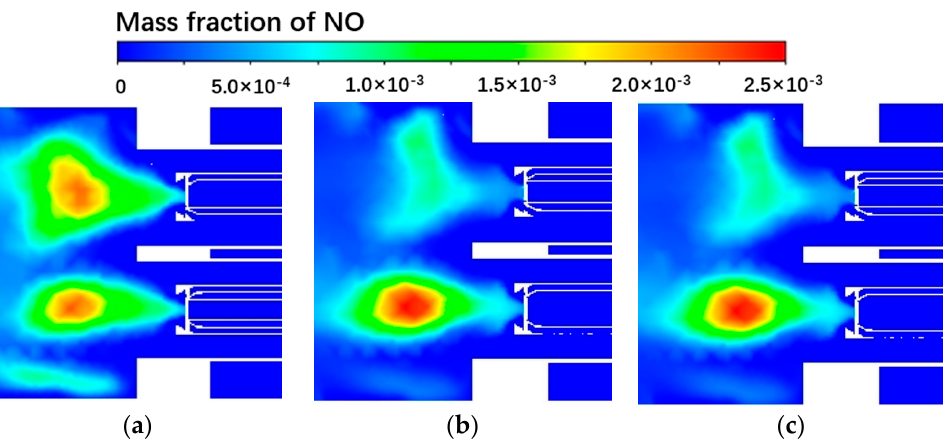
Figure 11. Calculation results of NOx distribution in each mode during startup stage. ( a ) Diffusion; ( b ) Sub-pilot premix; ( c ) Pilot premix.